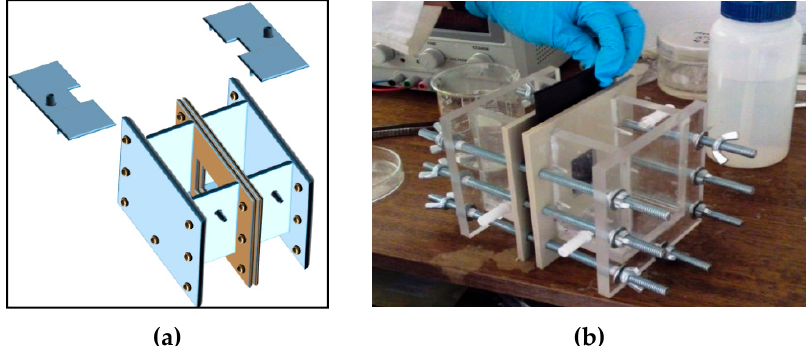
Figure 2. Membrane electrodialysis cell design with two compartments. ( a ) Computer design, ( b ) cell built in acrylic.